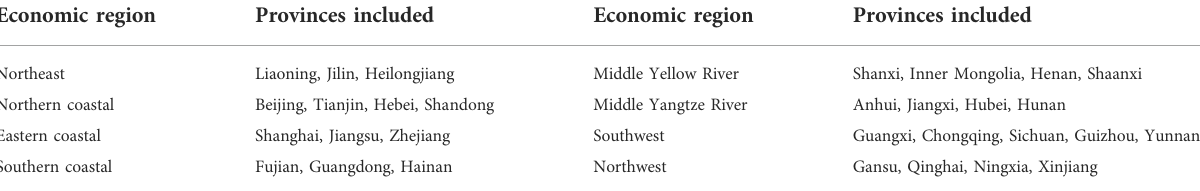
Yellow River ranks third, the TC index ranks fi rst, and the EC index